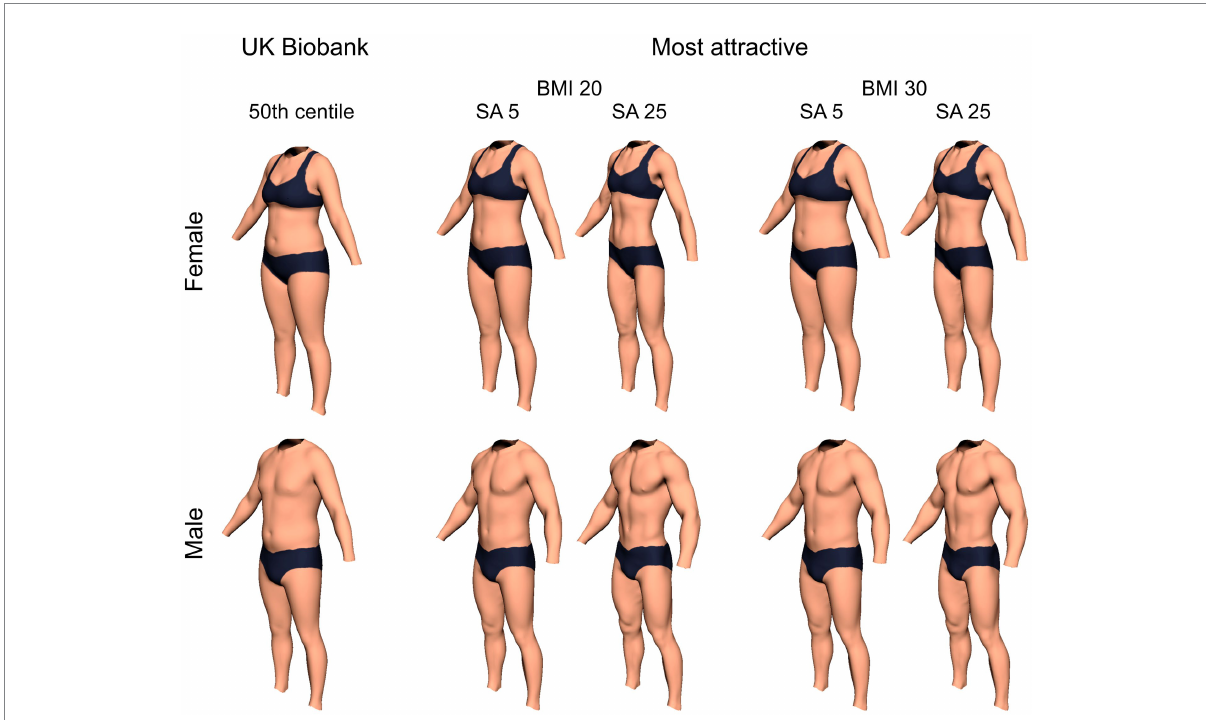
FIGURE 6 Illustrations of male and female bodies corresponding to the UK Biobank 50th centile, and for observers with BMIs of 20 and 30 respectively, divided further according to their SATAQ athletic (SA) scores of 5 (minimum) and 25 (maximum) respectively. Using the modelling technique of Maalin et al. (2021), set to the nearest 1 kg increment, the male UK Biobank body has a composition of Adipose 19.0 kg and Muscle of 37.0 kg. When the observer has a BMI of 20, the male SATAQ 5 body has Adipose of 14.0 kg and Muscle 55.0 kg, and the male SATAQ 25 body has Adipose of 6.0 kg and Muscle of 68.0 kg. When the observer has a BMI of 30, the male SATAQ 5 body has Adipose of 17.0 kg and Muscle 57.0 kg, and the male SATAQ 25 body has Adipose of 9.0 kg and Muscle of 70.0 kg. The Female UK Biobank body has Adipose 22.0 kg and Muscle 24.0 kg. When the observer has a BMI of 20, the female SATAQ 5 body has Adipose of 16.0 kg and Muscle 32.0 kg, and the female SATAQ 25 body has Adipose of 3.0 kg and Muscle of 43.0 kg. When the observer has a BMI of 30, the female SATAQ 5 body has Adipose of 23.0 kg and Muscle 32.0 kg, and the female SATAQ 25 body has Adipose of 9.0 kg and Muscle of 43.0